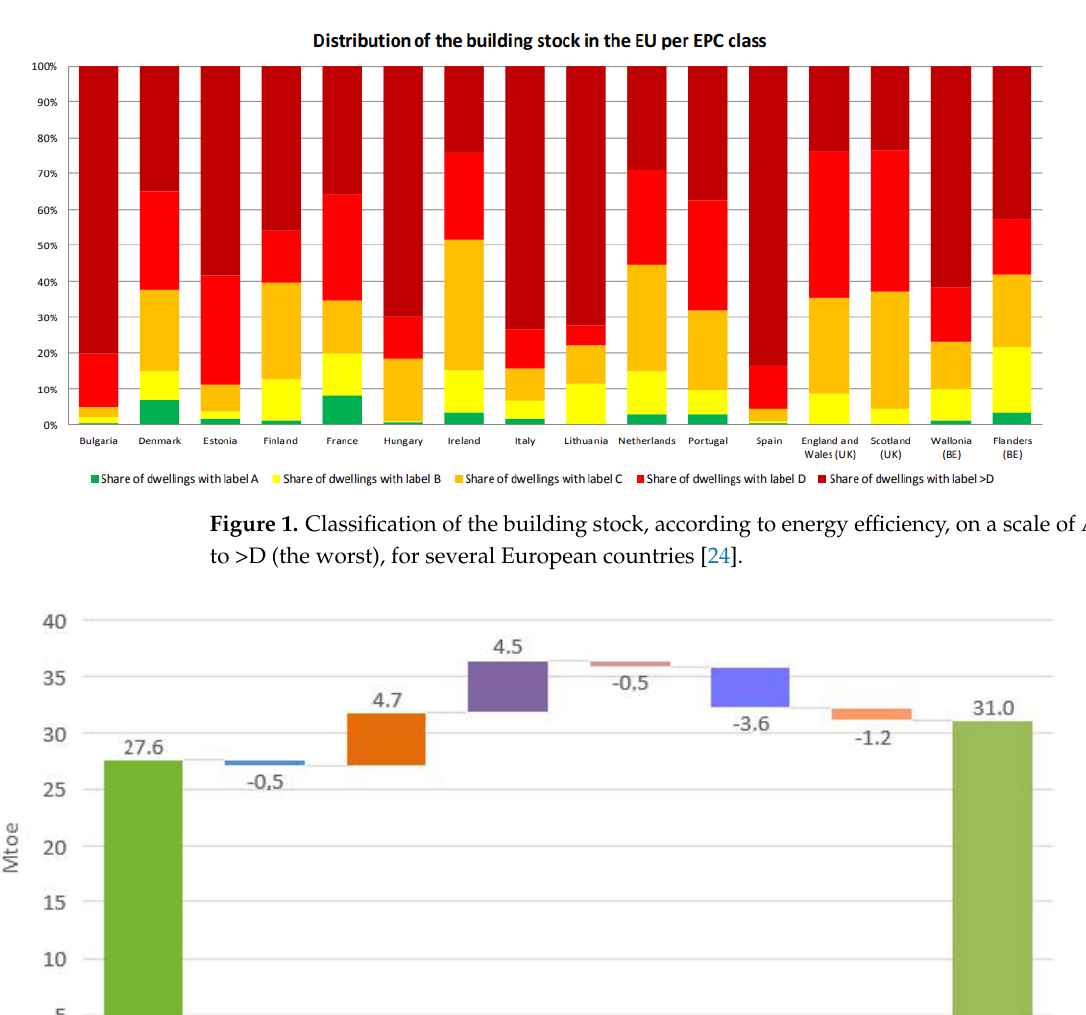
Figure 1. Classification of the building stock, according to energy efficiency, on a scale of A (the best) to >D (the worst), for several European countries [24].